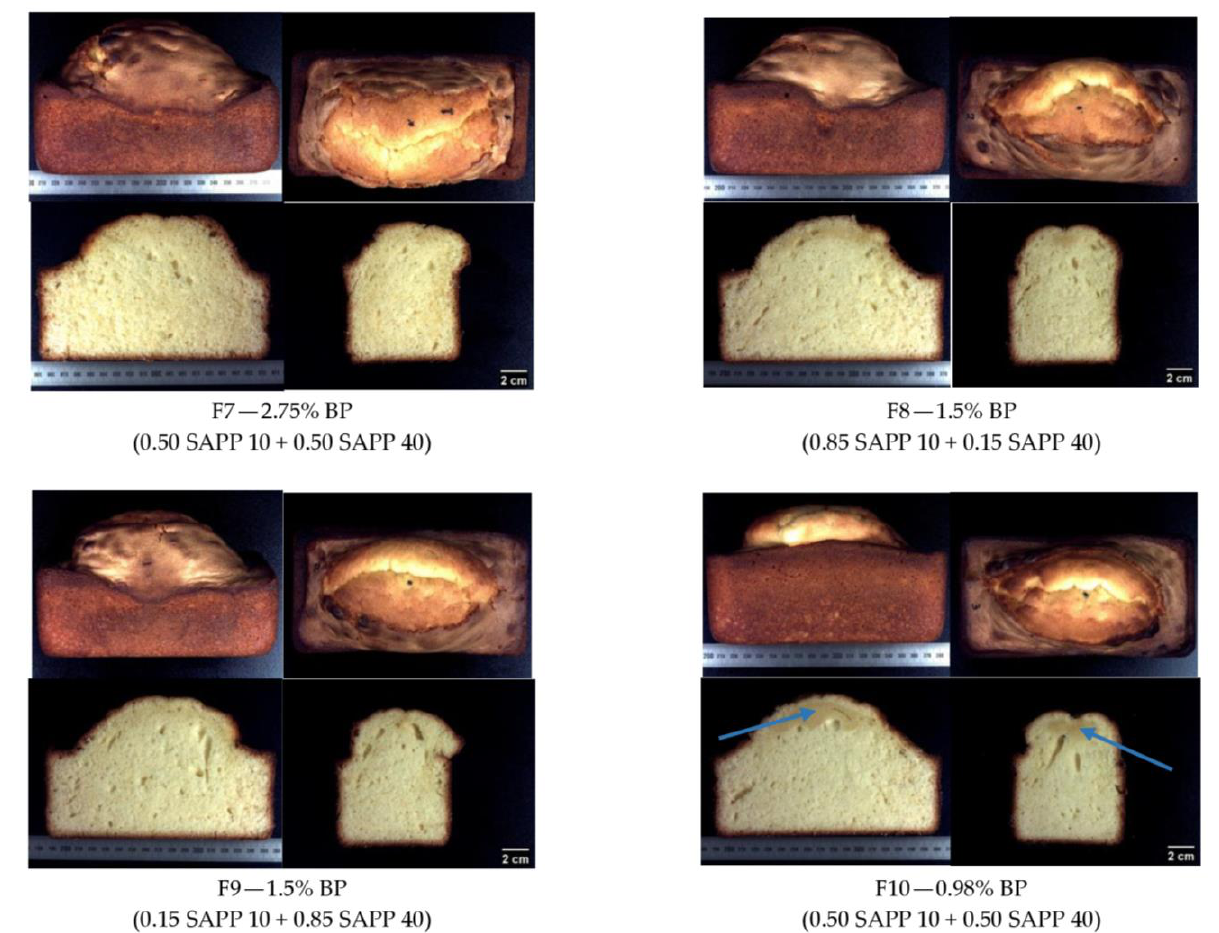
Figure 5. The appearance of pound cakes with different baking powder amounts and corresponding levels of SAPPs. The blue arrows indicate partially cooked parts of cake. F = formulation.